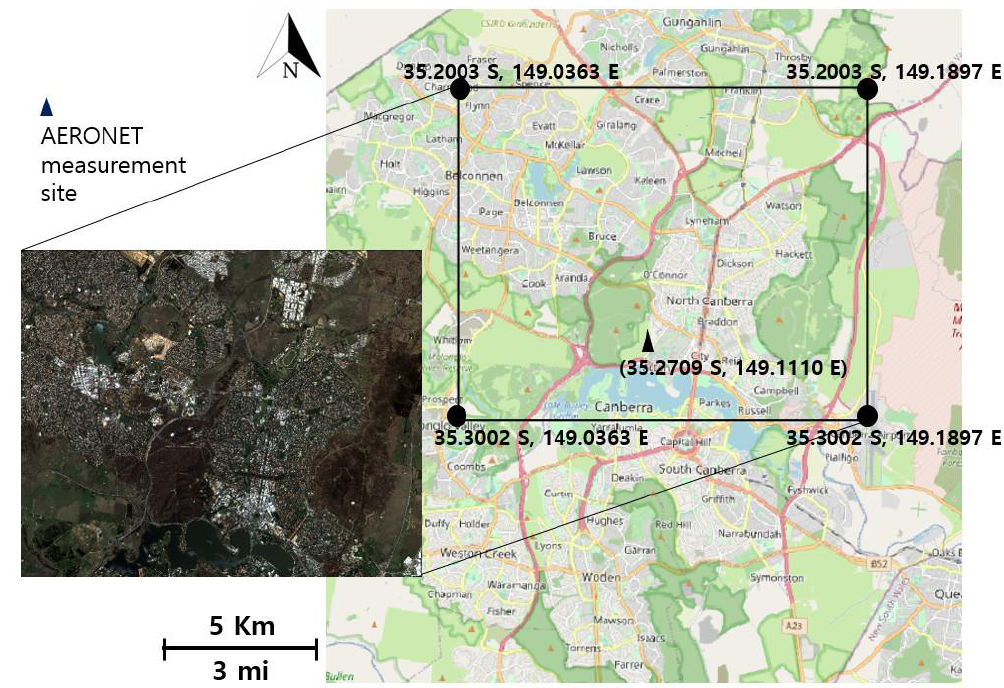
Figure 5. Canberra region, Australia (covered by KOMPSAT-3A on 7 February 2016) and AERONET measurement station on OpenStreetMap (OSM). measurement station on OpenStreetMap (OSM). Remote Sens. 2020 , 12 , x FOR PEER REVIEW